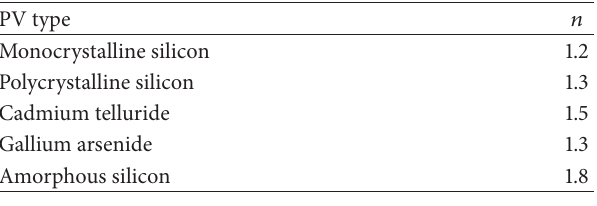
Figure 4: Solar cell circuit diagram. 𝐼 saturation current, 𝑅 𝑠 : serial resistance, 𝑅 ambient temperature, 𝐺 : ambient irradiance, and 𝑉 : output voltage.